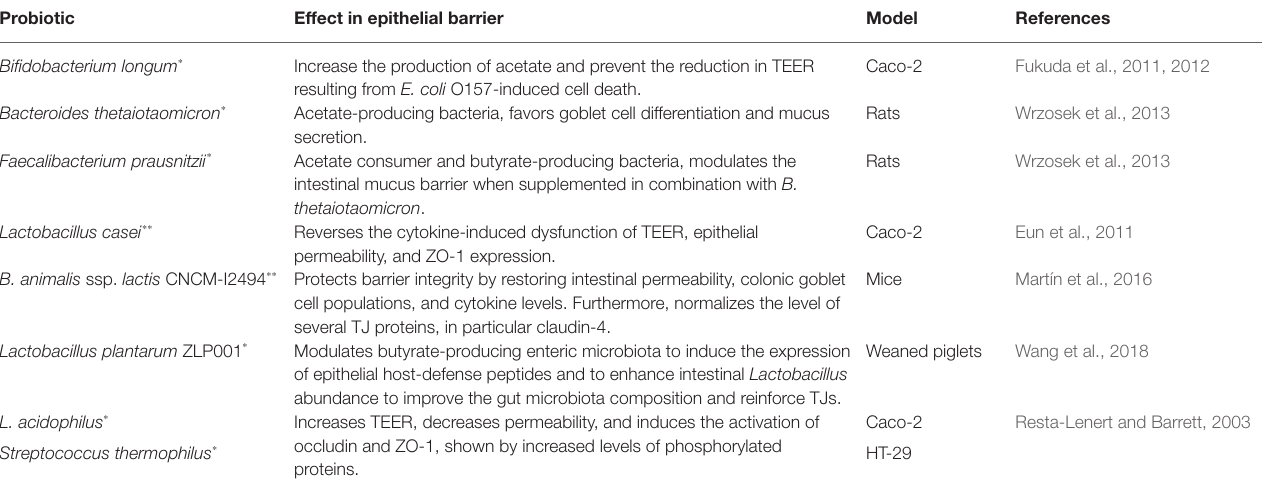
TABLE 1 | Summary of probiotics effects on epithelial barrier function in vitro and in vivo